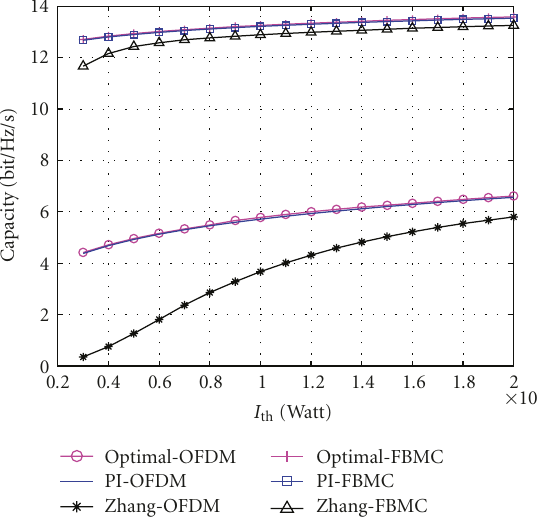
Figure 8: Total interference introduced to the PU 1 versus interfer- ence threshold.